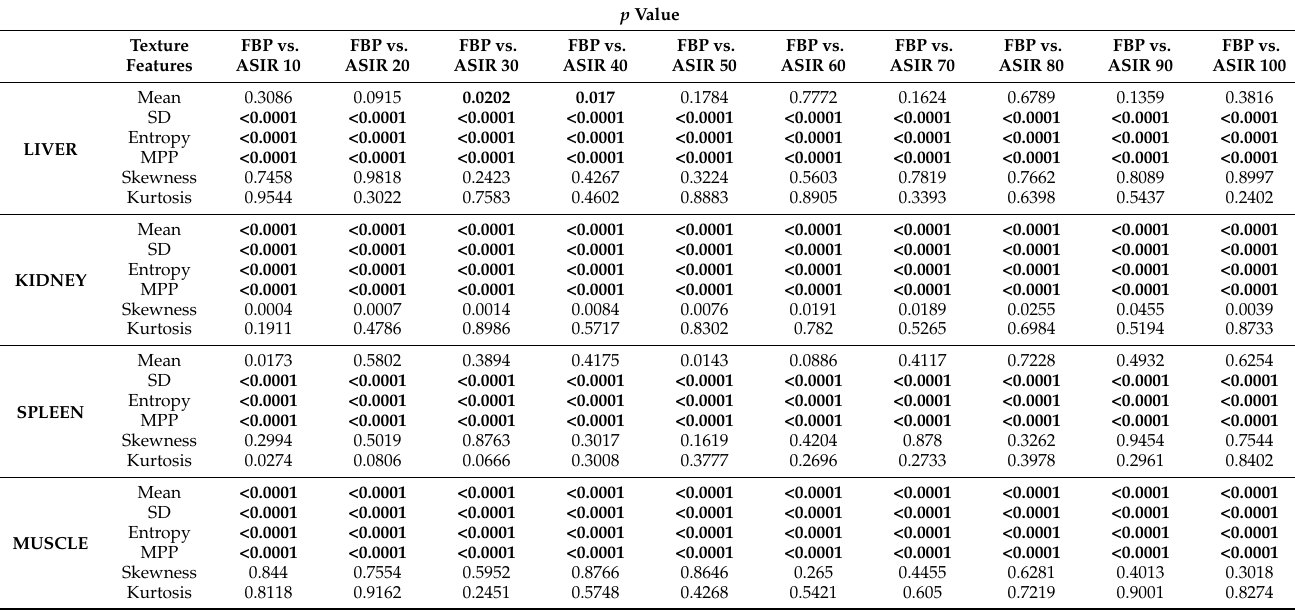
Table 1. Results of CT texture analysis (CTTA) of the liver (A), kidney (B), spleen (C) and muscle (D) on unfiltered images; each feature (standard deviation (SD), mean, entropy, mean of positive pixels (MPP), skewness and kurtosis) is compared between filtered back projection (FBP) and all Adaptive Statistical Iterative Reconstruction-V (ASIR-V) reconstructions. Significant p in bold. p